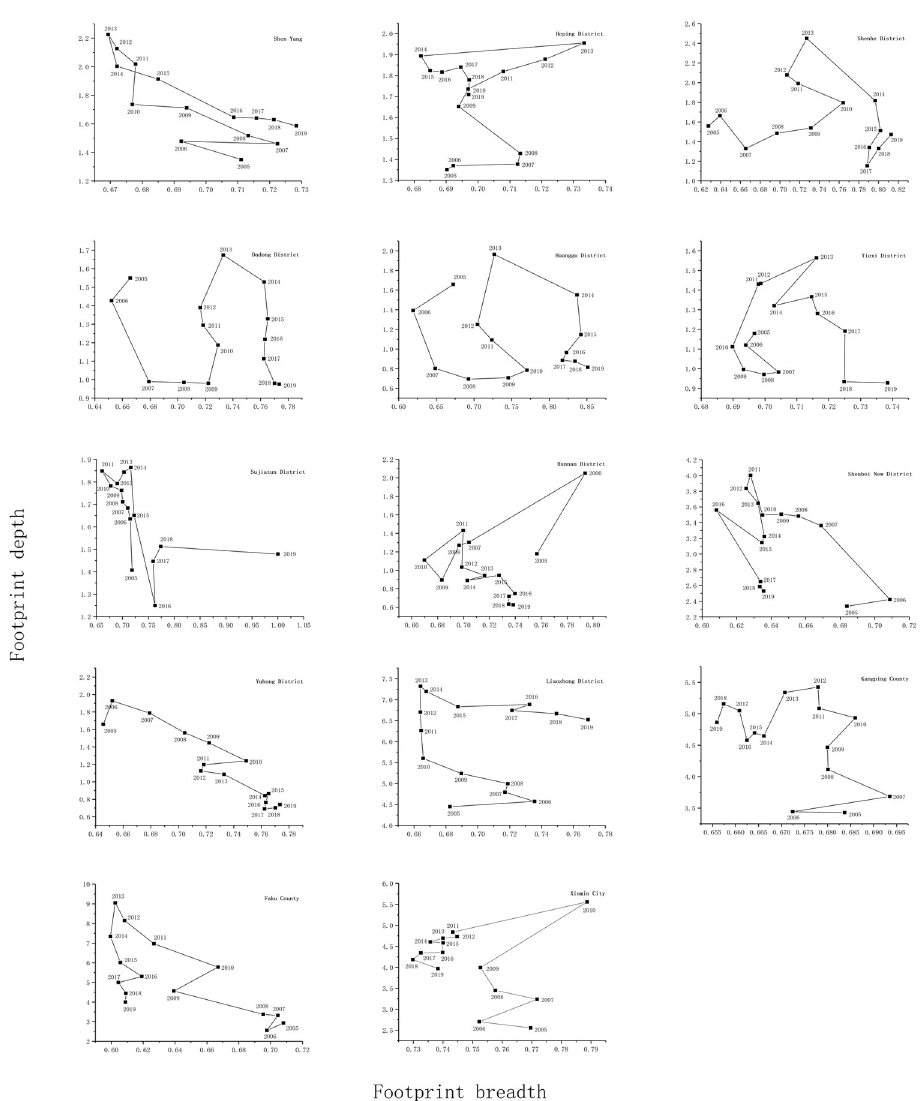
Fig 4. Time series of the relationship between footprint breadth and footprint depth in Shenyang